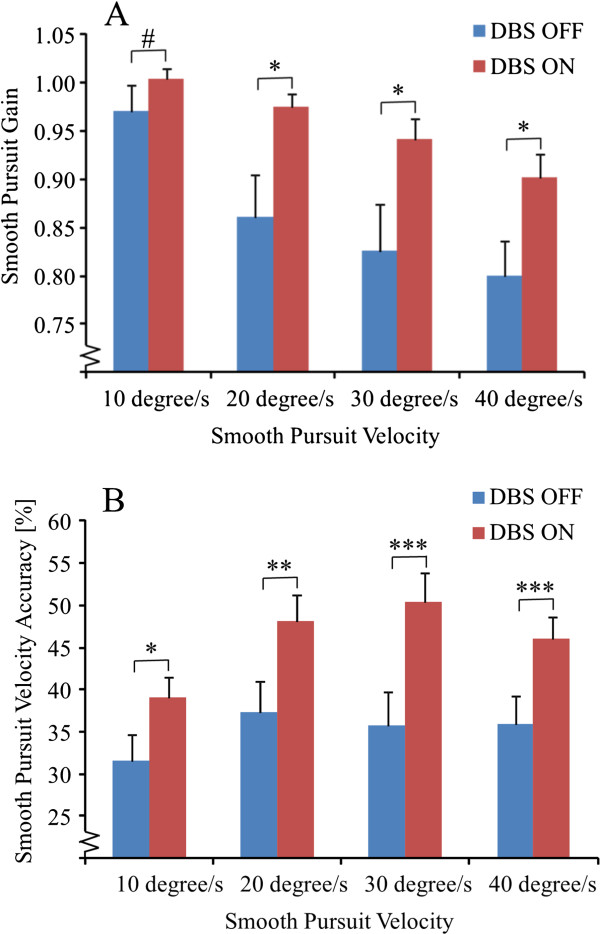
A Gain values (mean and SEM) for four target velocities with DBS OFF and ON. A value below 1.00 represent that the average smooth pursuit velocity was below the target velocity. B: Smooth pursuit velocity accuracy values (mean and SEM) with DBS OFF and ON. A value of 100 % represents that the eye movement velocity were always within the boundaries. (# denotes P < 0.1; * denotes P < 0.05; ** denotes P < 0.01 and *** denotes P < 0.001).